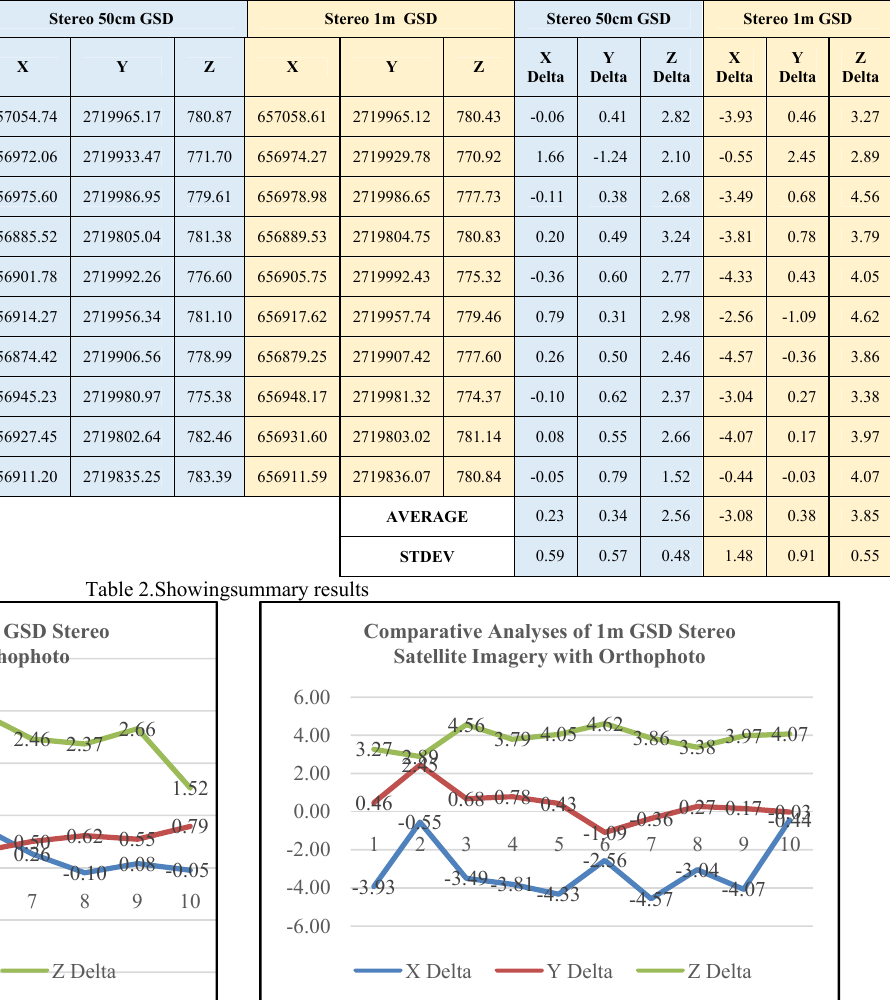
Figure 2. Comparative analyses of data digitized from 50cm GSD Stereo Satellite Imagery with 10cm GSD Orthophoto